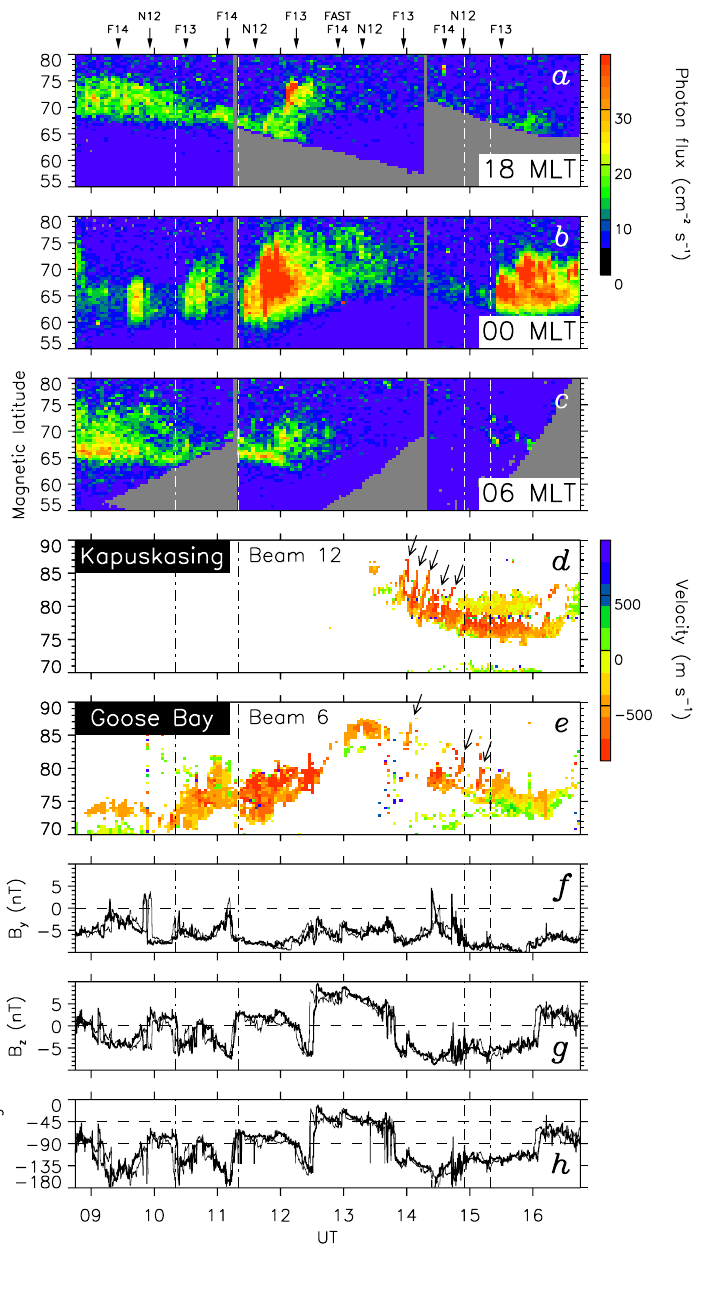
Fig. 2. (a–c) Latitude-time-intensity plots of the UV auroral luminosity along the dusk, midnight, and dawn meridians, respectively. (d–e) Latitude- time-velocity plots of radar data from the Kapuskasing and Goose Bay radars of the SuperDARN chain. Arrows in- dicate poleward-moving radar auroral forms (PMRAFs), signatures of bursty reconnection. (f–g) The B y and B z components of the IMF as measured by the Wind and ACE spacecraft (thick and thin lines, respectively), lagged to the magnetopause. (h) The IMF clock angle determined from the Wind and ACE observations. Vertical dot-dashed lines indicate (in order) the first auro- ral brightening, followed by the onset of the first substorm breakup, the post- midnight auroral brightening, and the onset of the second substorm breakup, as determined from the UVI observa- tions (see text for